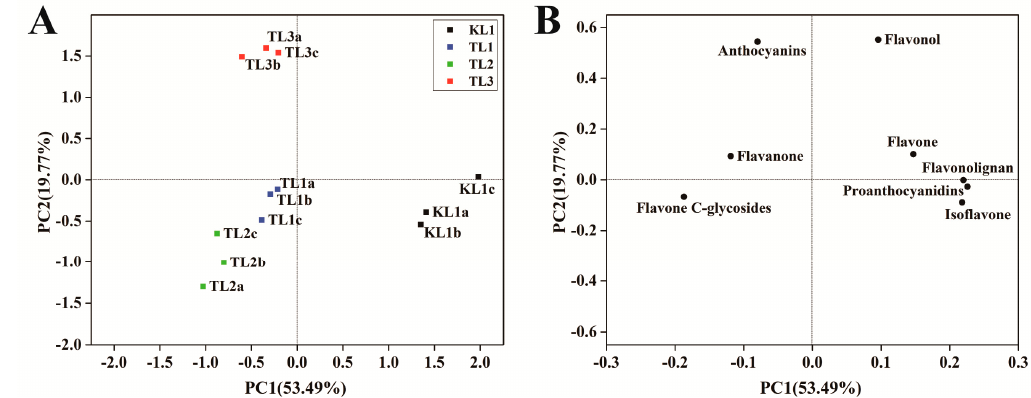
Figure 3. Differential flavonoid metabolite analysis on the basis of principal component analysis (PCA). ( A ) PCA score plot ( B ) PCA loading plot.